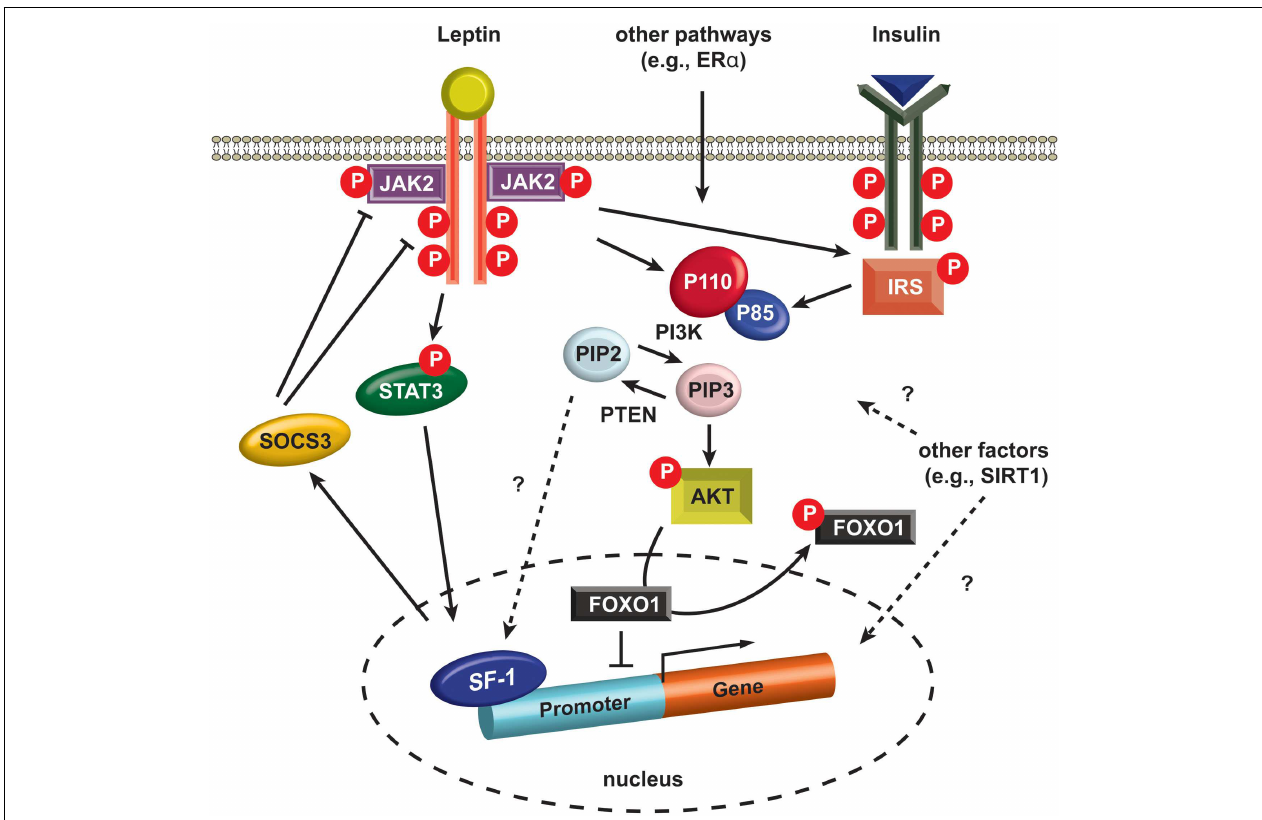
induces phosphorylation of FOXO1 (pFOXO1) in the nucleus. pFOXO1 is translocated to the cytosol. FOXO1 directly binds SF-1 and inhibit SF-1 activity. AKT, serine/threonine-specific protein kinase. FOXO1, Forkhead box protein O1. JAK2, janus kinase 2. IRS, insulin receptor substrate. STAT3, signal transducer and activator of transcription. PIP2, phosphatidylinositol (4,5)-bisphosphate. PIP3, phosphatidylinositol (3,4,5)-triphosphate, PTEN, phosphatase and tensin homolog. P110, p110 catalytic subunit. P85, p85 regulatory subunit. SIRT1, sirtuin 1 or silent mating type information regulation 2. SF-1, steroidogenic factor-1. SOCS3, suppressor of cytokine